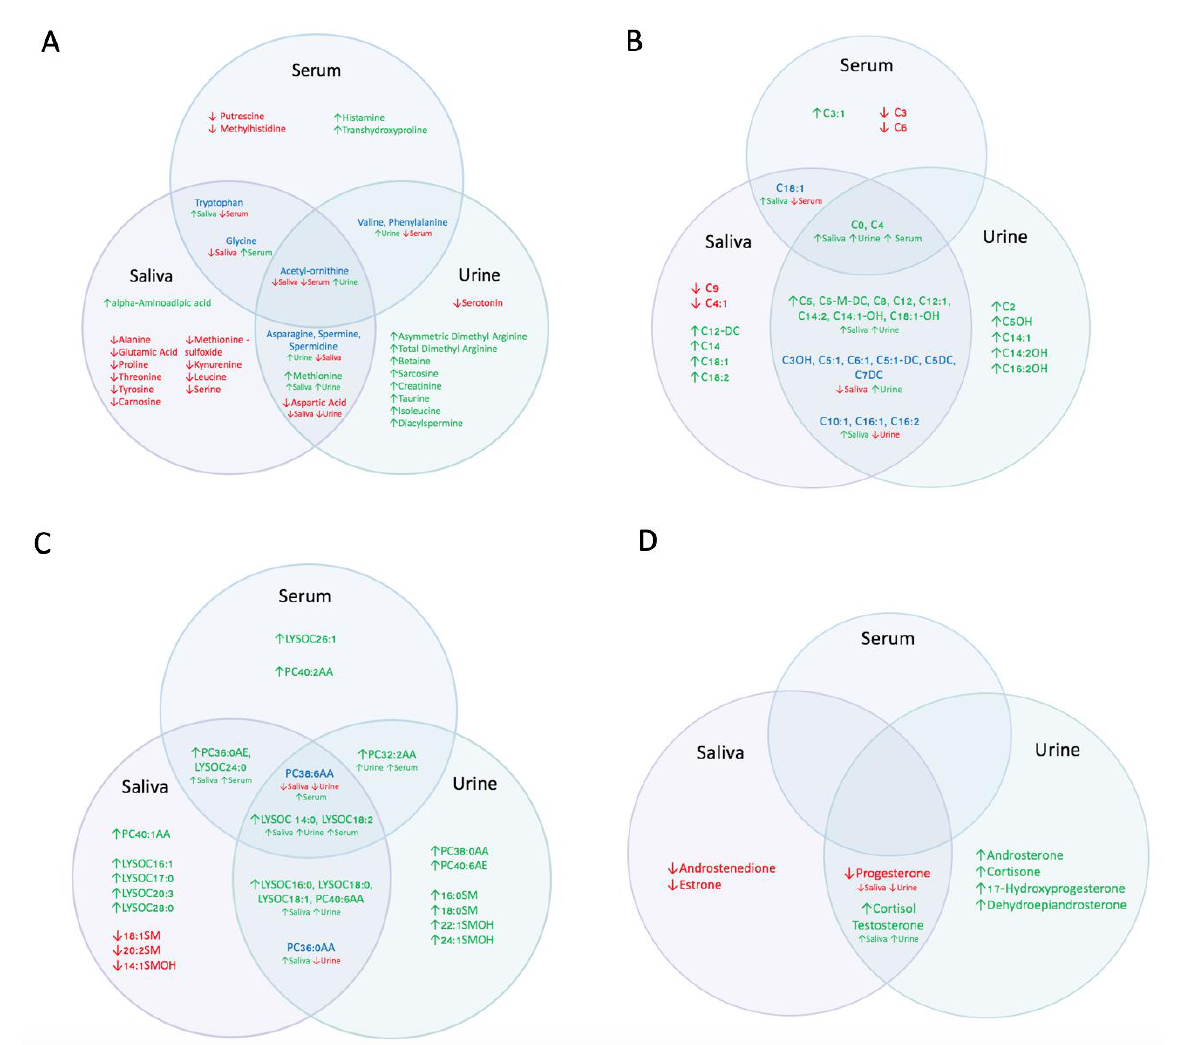
Figure 4. Comparison of the metabolite changes of amino acid ( A ), fatty acid oxidation ( B ), lipid membrane ( C ) and steroid hormone ( D ) metabolite groups in serum, urine and saliva between HRP and INF pigs. Red metabolites indicate a decrease in the concentration of the metabolite in HRP compared to INF, green metabolites indicate an increase in the concentration of the metabolite in HRP compared to INF, and blue metabolites indicate metabolites that have variable changes in the metabolite across more than one biofluid, with the direction of their changes indicated by the arrow and corresponding biofluid underneath.